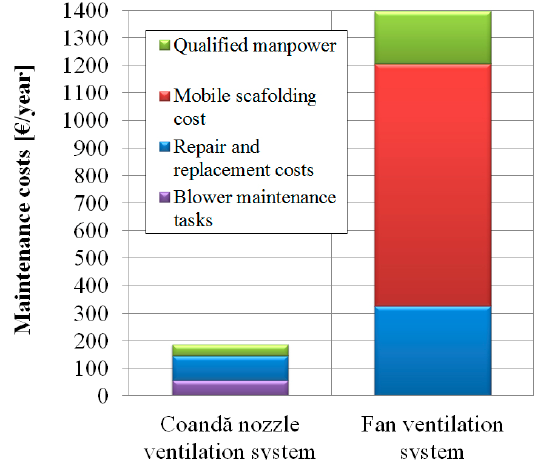
Figure 8. Comparison between maintenance costs of both ventilation systems